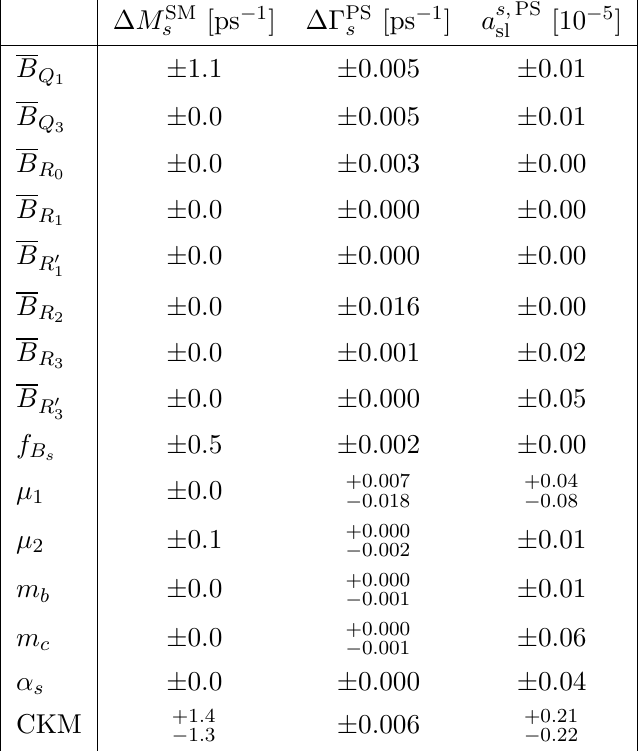
Table 6 . Individual errors for the B s mixing